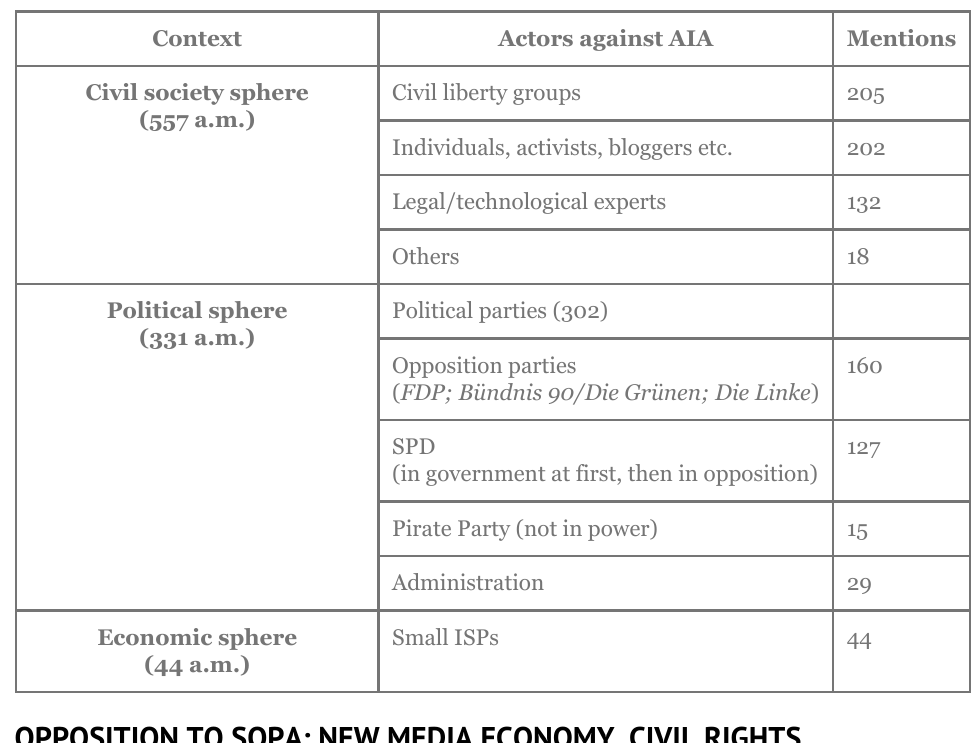
Table 2: Mentions by actors against AIA